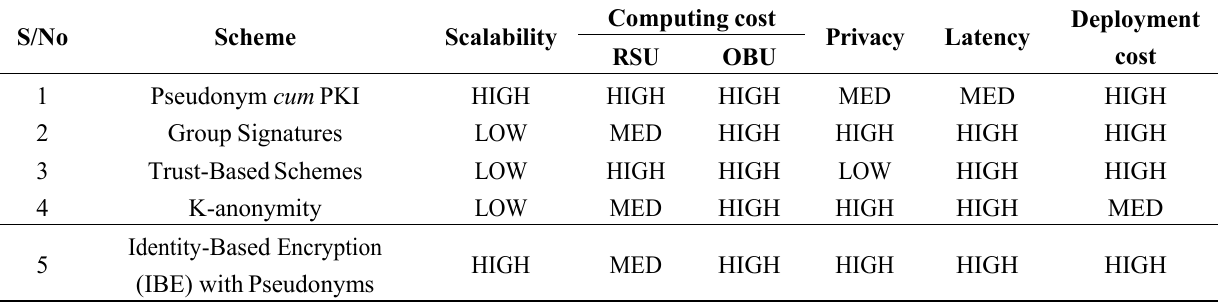
Table 1. Performance metrics for security schemes in